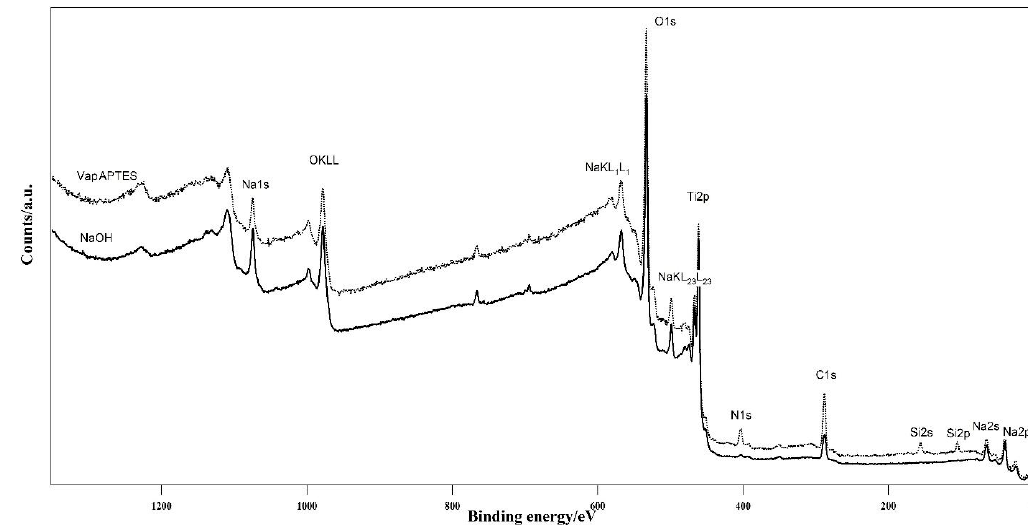
Figure 5. Comparison of the survey spectra of the samples after NaOH etching but before functionalization (NaOH) and after aminopropyltriethoxysilane (APTES) (VapAPTES) functionalization. Successful attachment of APTES is evidenced by the presence of nitrogen and silicon species, which were not present on the bare Ti-6Al-4V surface. Table 1. Surface atomic percentages on samples at different steps of the production process. Composition was obtained for the most relevant elements identified by XPS.